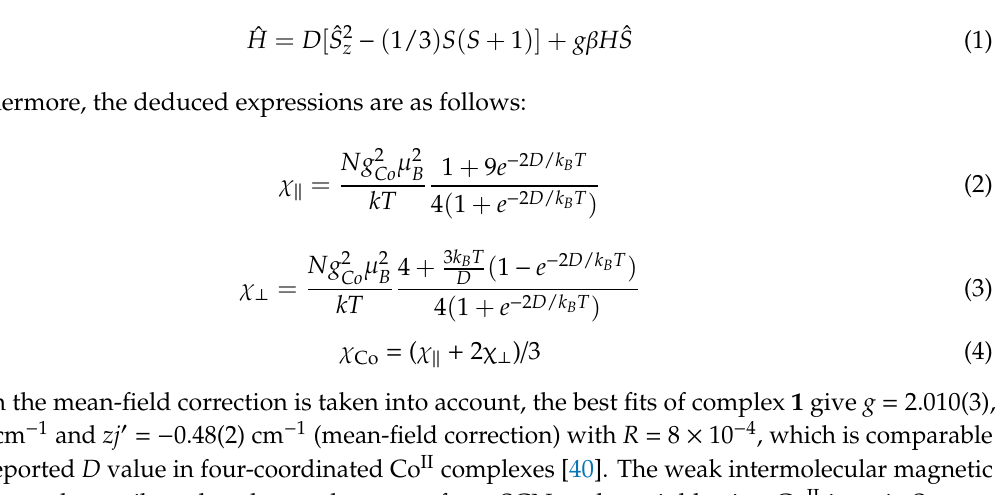
Figure 4. Temperature dependence of the χ M T product for complex 1 under an applied field of 100 Oe.